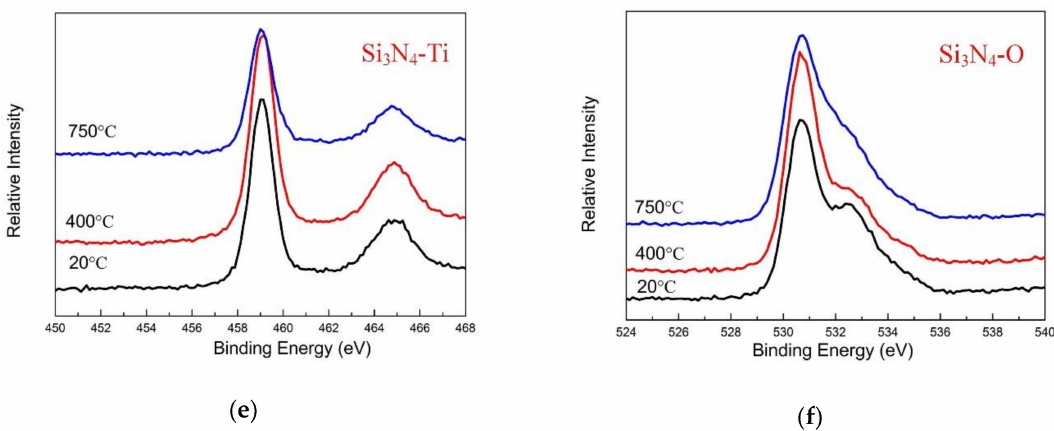
Figure 9. X-ray photoelectron spectroscopy (XPS) spectra of Al, Ti, and O on the worn surfaces of the Ti-22Al-25Nb alloy at different temperatures with the friction pair of Al 2 O 3 and Si 3 N 4 . ( a ) XPS of Al with the friction pair of Al 2 O 3 at different temperature, ( b ) XPS of Ti with the friction pair of Al 2 O 3 at different temperature, ( c ) XPS of O with the friction pair of Al 2 O 3 at different temperature, ( d ) XPS of Al with the friction pair of Si 3 N 4 at different temperature, ( e ) XPS of Ti with the friction pair of Si 3 N 4 at different temperature, ( f ) XPS of O with the friction pair of Si 3 N 4 at different temperature.